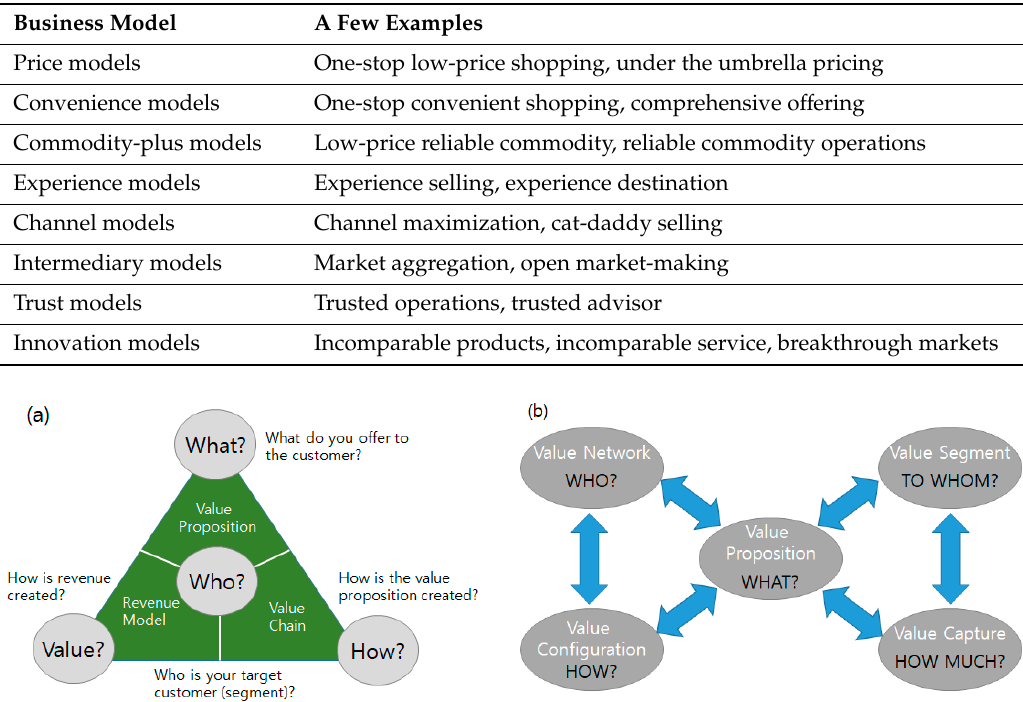
Figure 1. ( a ) The conceptual triangle for the St. Gallen business model navigator by Grossmann et al. [20] and ( b ) the five-V framework for business model configuration by Taran et al. [21].